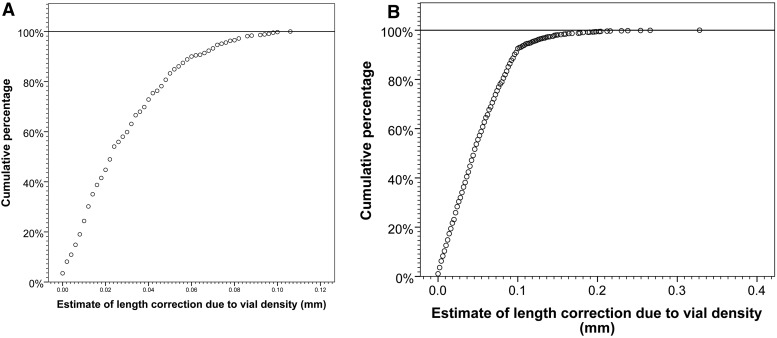
Magnitude of potential correction of pupal length for vial density, using Equation 1. The more uniform vial densities from single pair matings (A) resulted in all but one vial being within 50 pupae of the mean observed density of 65, corresponding to a maximum correction for density of 0.1 mm (n = 431 vials). The increased variance of the vial densities resulting from establishing vials from small groups of RIL individuals (B) led to ∼5% of vials being corrected by >0.1 mm (n = 1620 vials). A calculated mean density (M) of 65 was used for all vials. A slope value of S = −0.002 was used, if a steeper slope is used then there would be a corresponding increase in the magnitude of the corrections. All vial with a density of <15 were excluded.